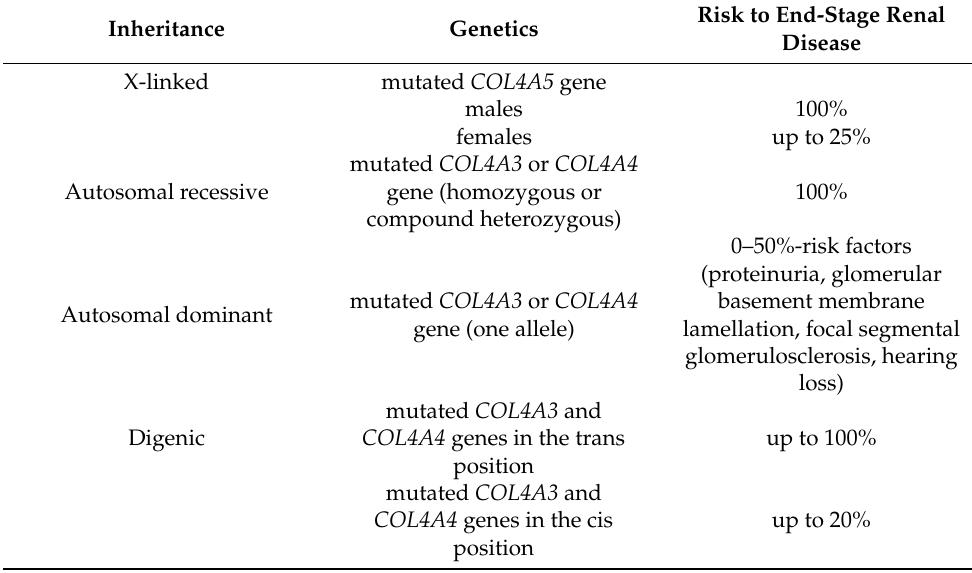
Table 1. Classification and prognosis of AS